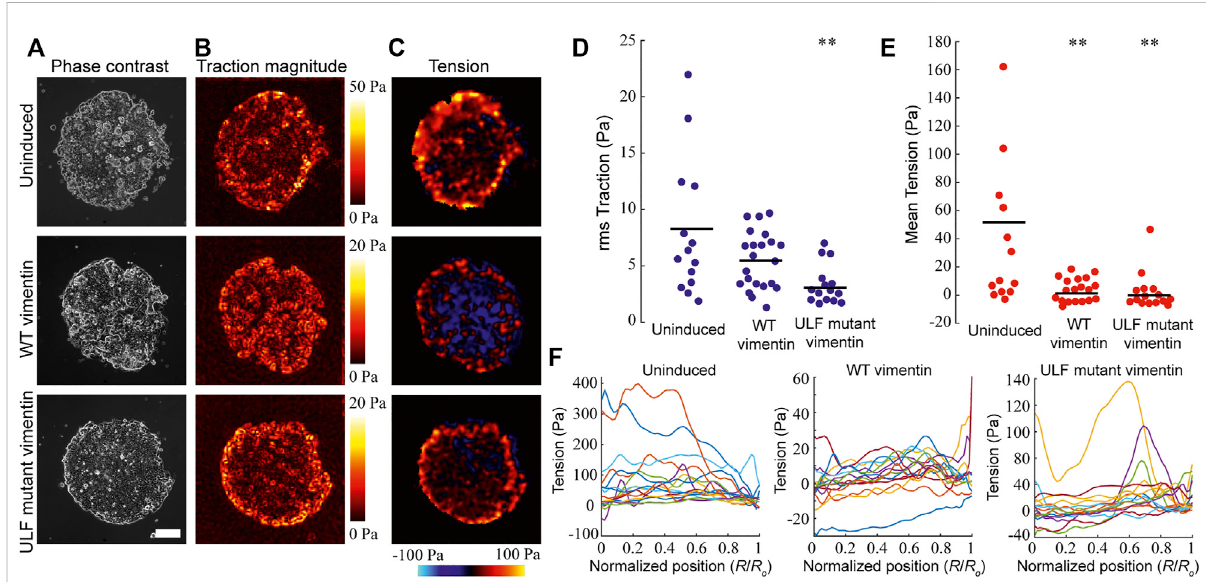
Vimentin expression reduced traction and intercellular forces in MCF7. (A) Representative phase contrast images of individual islands of uninducedMCF7cells,andcumate-inducedMCF7cellsexpressingeitherWTvimentinorULFmutantvimentin(scalebar200 μ m). (B) Colormapsof magnitude of cell-substrate traction of cell islands corresponding to the images in column (A) . (C) Color maps of intercellular tension of the cell islands (D) Root-mean-square(rms)tractionamonguninducedMCF7cells( n =14)andMCF7cellsexpressingeitherWTvimentin( n =21)orULF mutant vimentin ( n = 15). (E) Average of intercellular stress comparison among uninduced MCF7 cells ( n = 14), cumate-induced MCF7 cells expressing WT vimentin ( n = 21) or ULF mutant vimentin ( n = 15). In panels D and E, each dot represents an independent cell island, horizontal lines indicate means, and ** indicates p < 0.01 compared to uninduced (ANOVA with Bonferroni correction). (F) Intercellular stress plotted against normalized radial position, where 0 indicates the center of the cell island and R 0 is the radius of the cell island. Each line represents a different cell